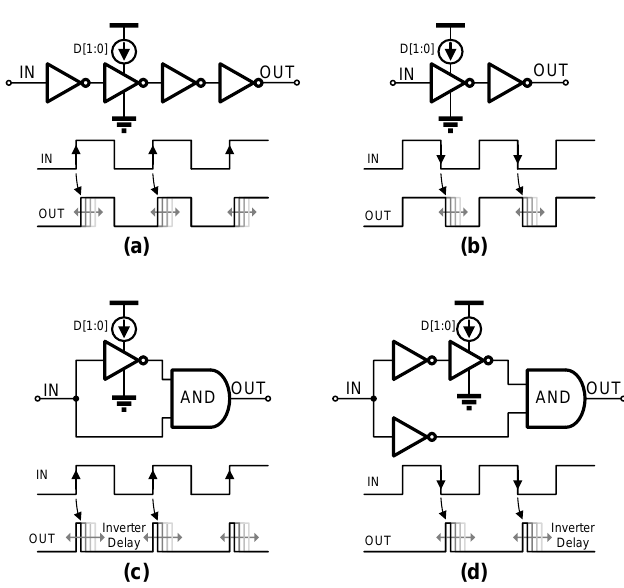
Figure 8. Time-delay based control units: ( a , b ) are the duty cycle controllers by positive and negative edge triggers, respectively, ( c , d ) are the one-shot generators triggered by positive and negative edges, respectively.